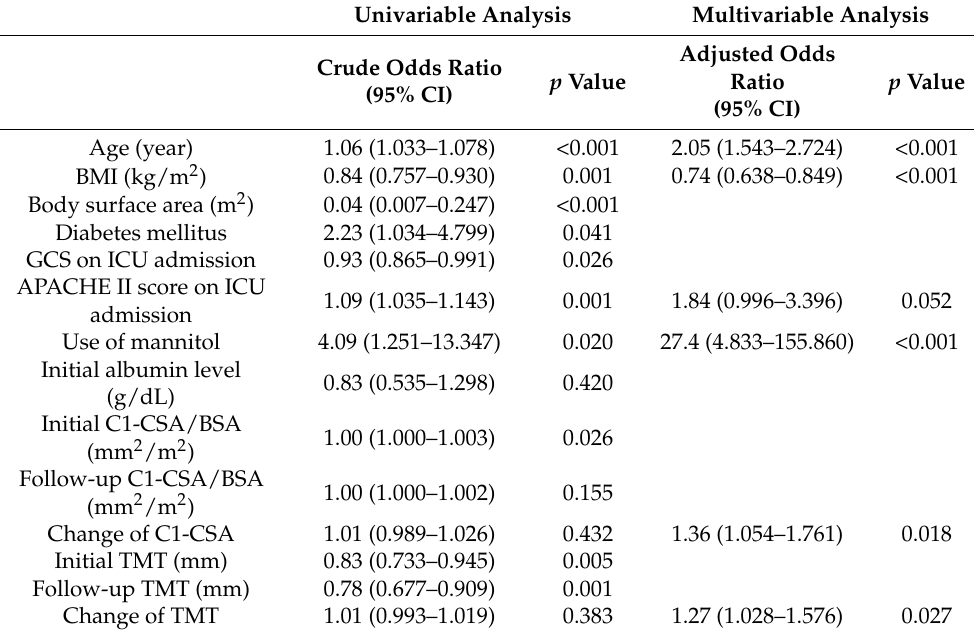
Table 3. Association between factors and poor neurologic outcome at 3 months.